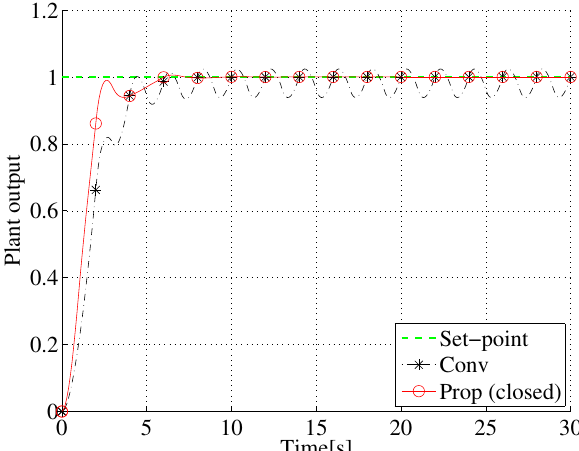
Figure 8. Output trajectories of unstable